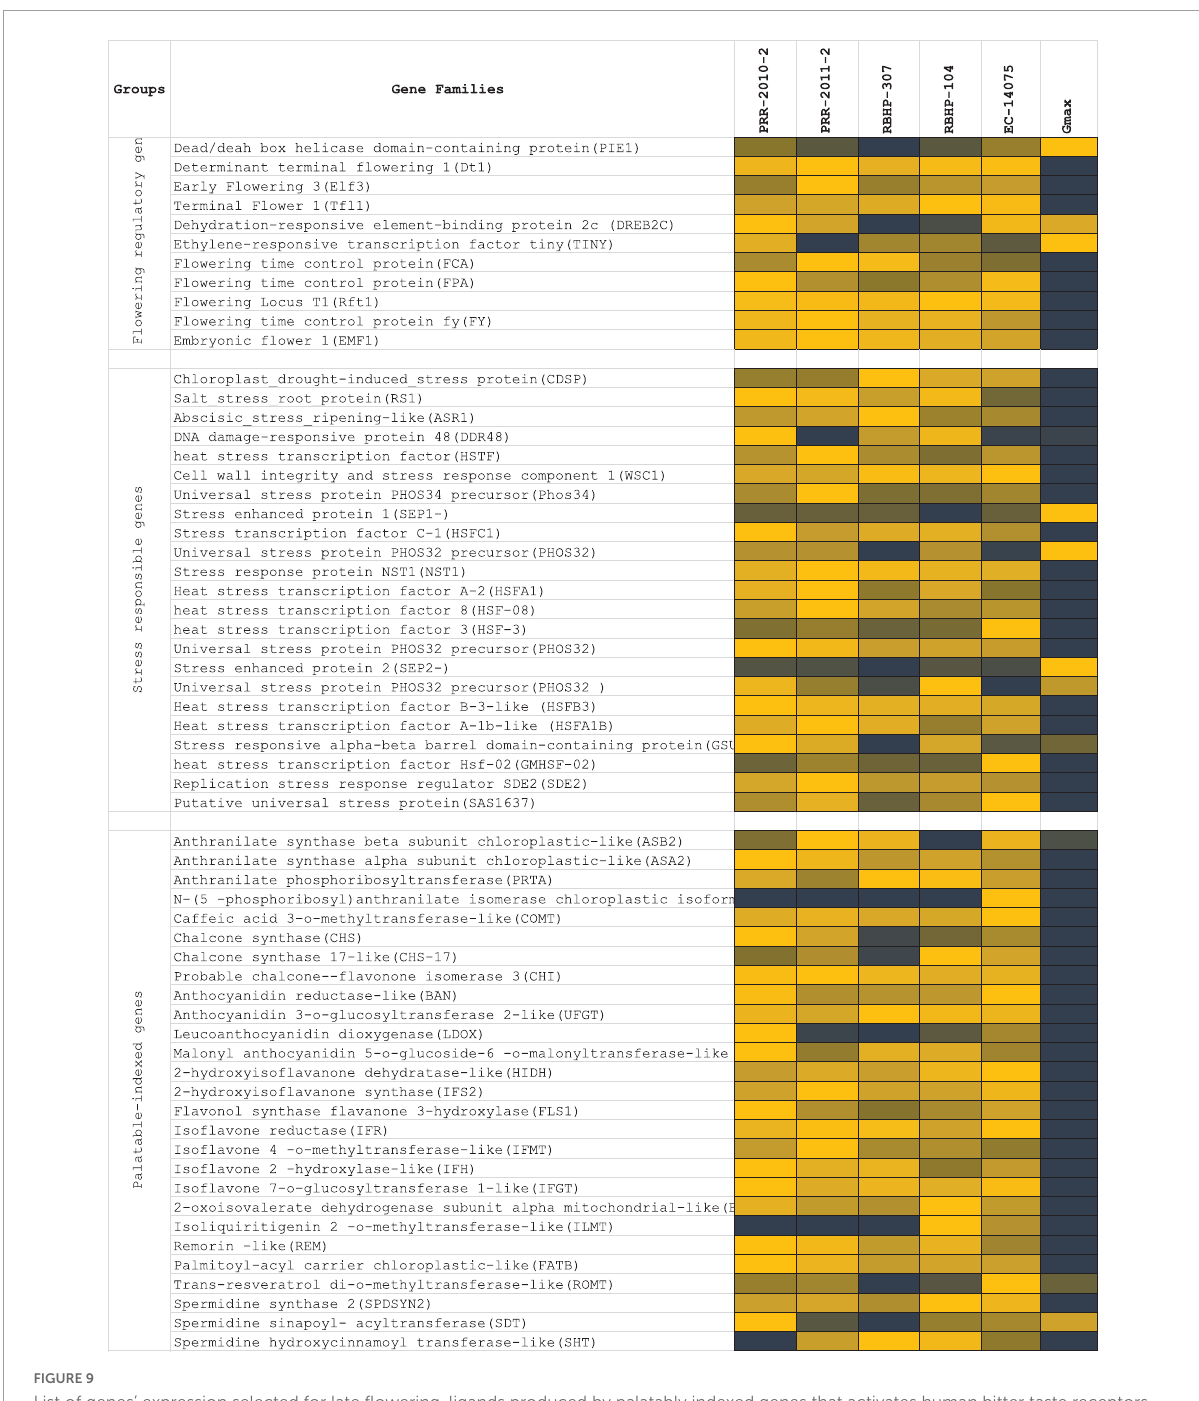
FIGURE9 List of genes’ expression selected for late flowering, ligands produced by palatably indexed genes that activates human bitter taste receptors, stress response genes, and disease resistance genes. RNA expressions of five rice bean varieties (log10 of RPKM of total read counts) and de novo assembled RNA expressions of Glycine max was compared for regulations of each functional genes selected for expression profile